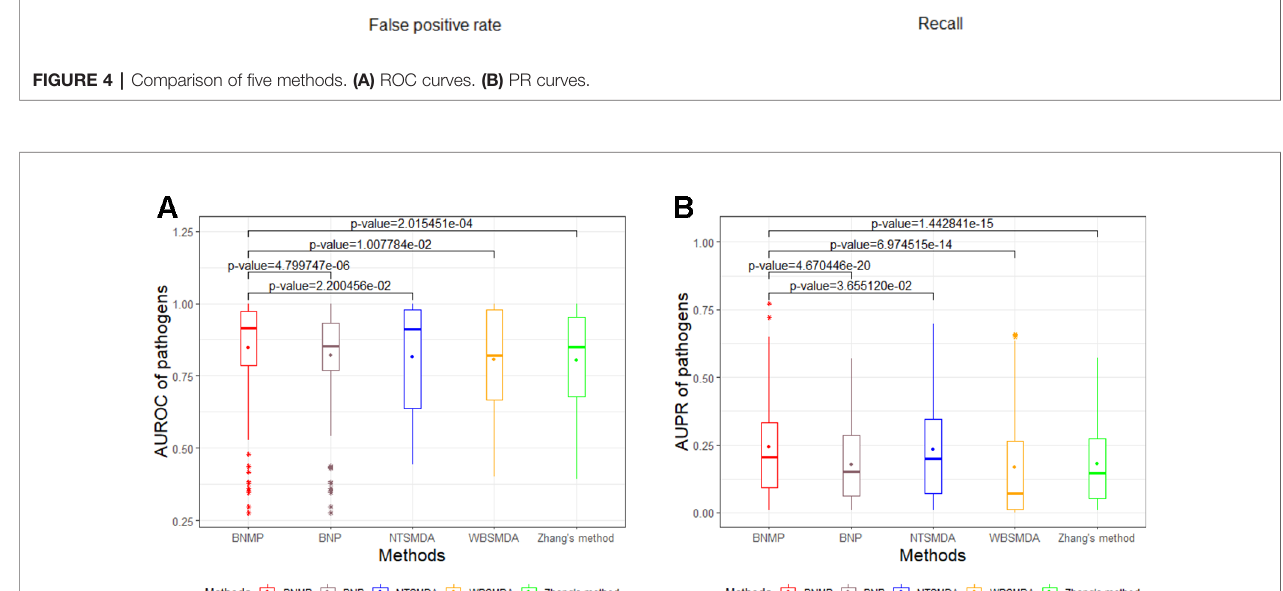
FIGURE 5 | Paired t -test for the AUROC and AUPR values of pathogens between BNMP and other methods. (A) Box-and-whisker plot of AUROC values with p -values. (B) Box-and-whisker plot of AUPR values with p